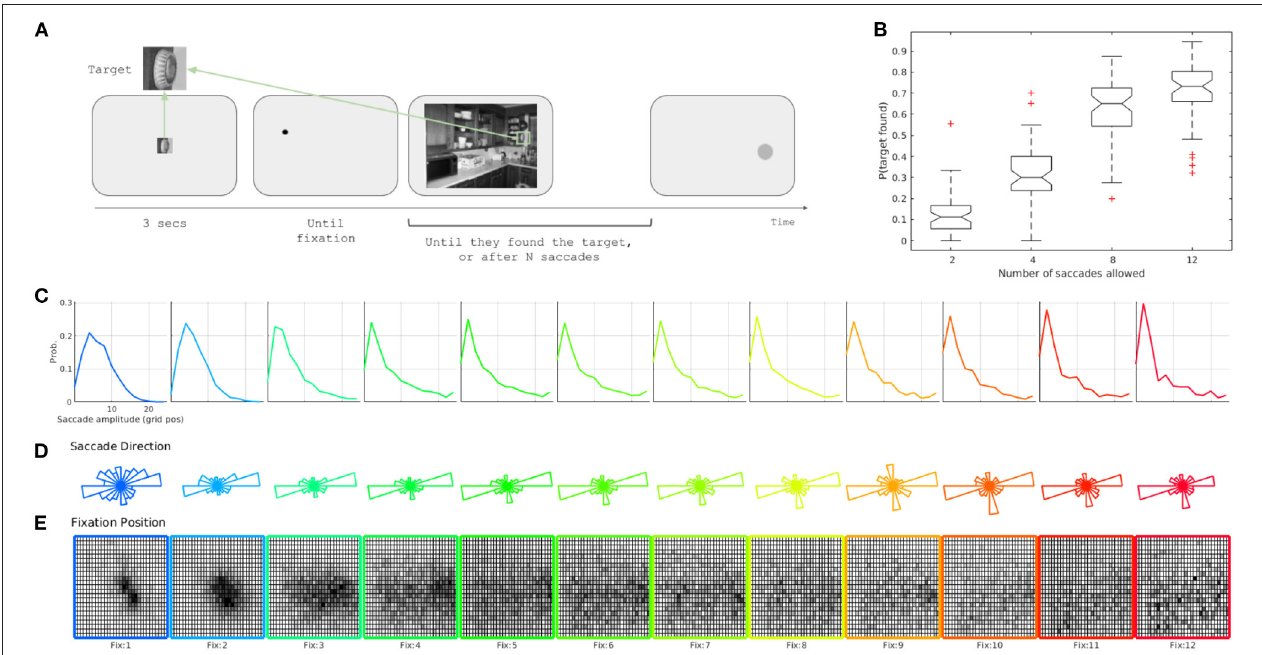
FIGURE 2 | Paradigm and general behavior. (A) Experimental schema. (B) Proportion of targets found as a function of the number of saccades allowed. Distributions of (C) saccade length, (D) saccade direction (measured in degrees from the positive horizontal axis), and (E) location of fixations for different fixation